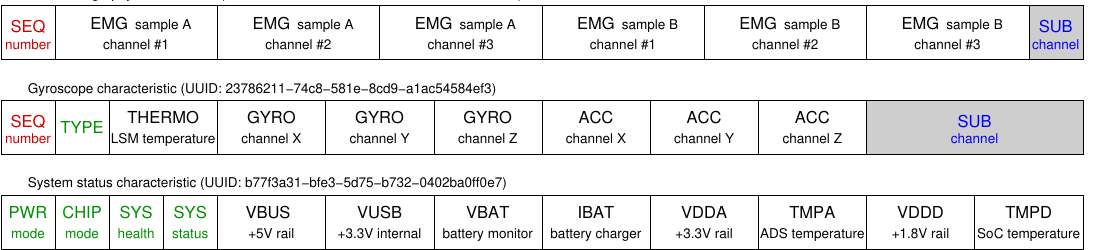
Figure 3. Illustration of the different packet structures. The maximum length of each packet is 20 bytes. Fields in a gray background are present only in a few packets and contain metadata with structure and timing information. The EMG data format is flexible so that different combinations of active channels and samples per packet are allowed, as described by the associated metadata, and can result in shorter packets, with anything between one and six samples per